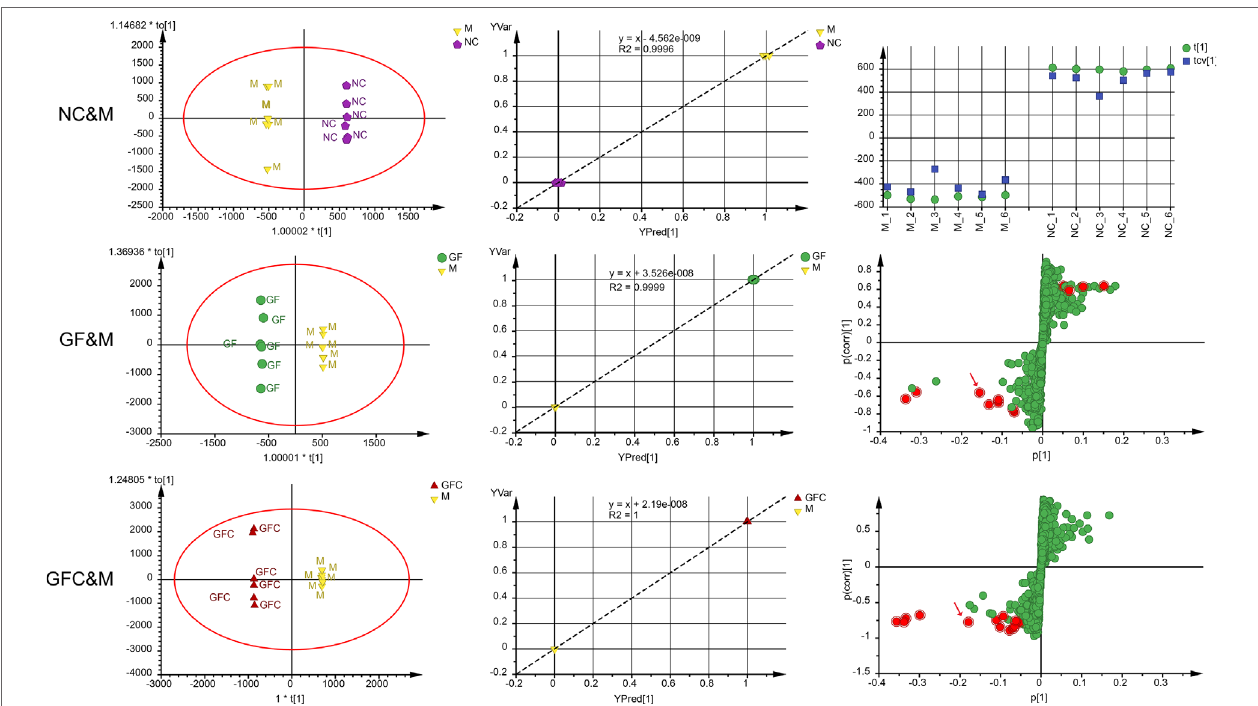
FIGURE 4 | Score plots, observation versus predicted plots, coefficient of variation (CV)-plot (NC&M), and s-plots using orthogonal partial least squares discriminant analysis (OPLS-DA) in the C18/UHPLC/MS system. Red points (red arrows) in s-plots show the putative ion features with 95%